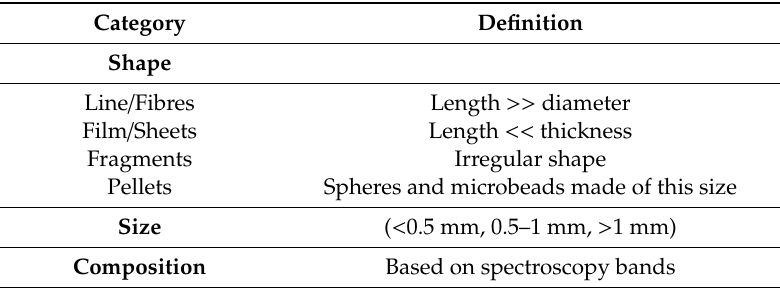
Table 1. Microplastics